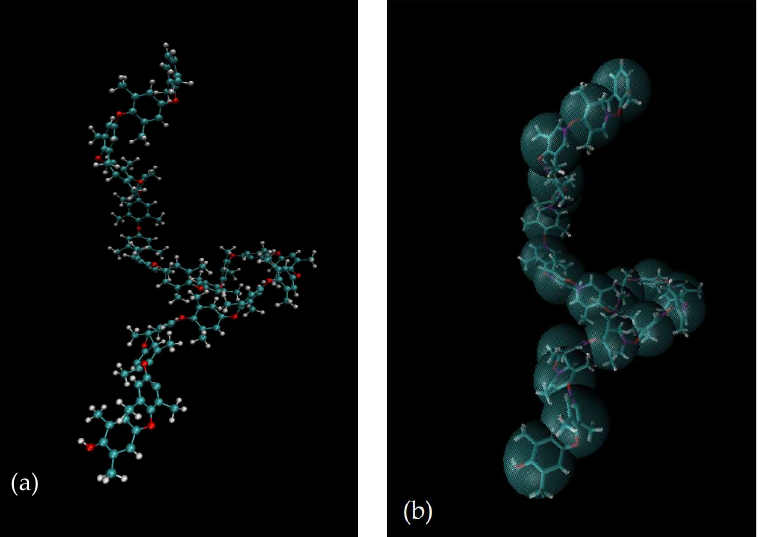
Figure 16. ( a ) All-atom representation of a polymer chain and ( b ) corresponding coarse-grained representation, where all atoms of the repeating unit are united into one bead.